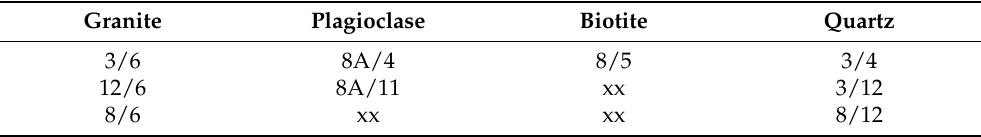
Table 1. BR developed through spectral analysis of spectra collected in the laboratory. The spectra were organised according to mineral samples.